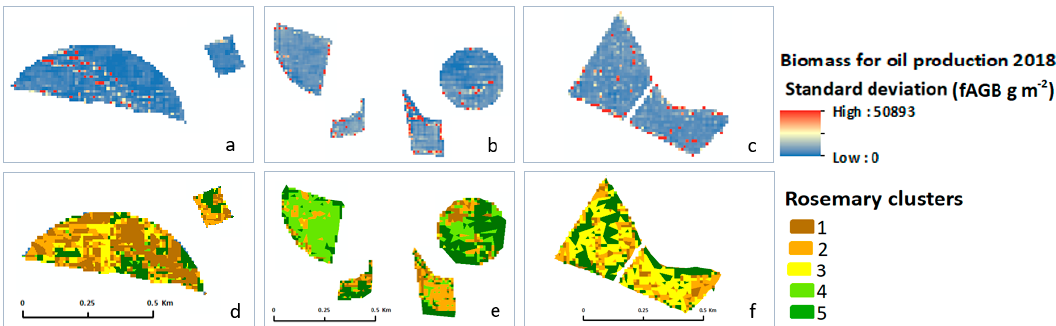
Figure 4. Standard deviation of biomass for essential oil production for 2018 ( a – c ) at the pixel level (10 m 2 ) in agricultural lands. Panels ( d – f ) show the respective spatial distribution of the five clusters within the rosemary fields, showing different levels of annual variation.